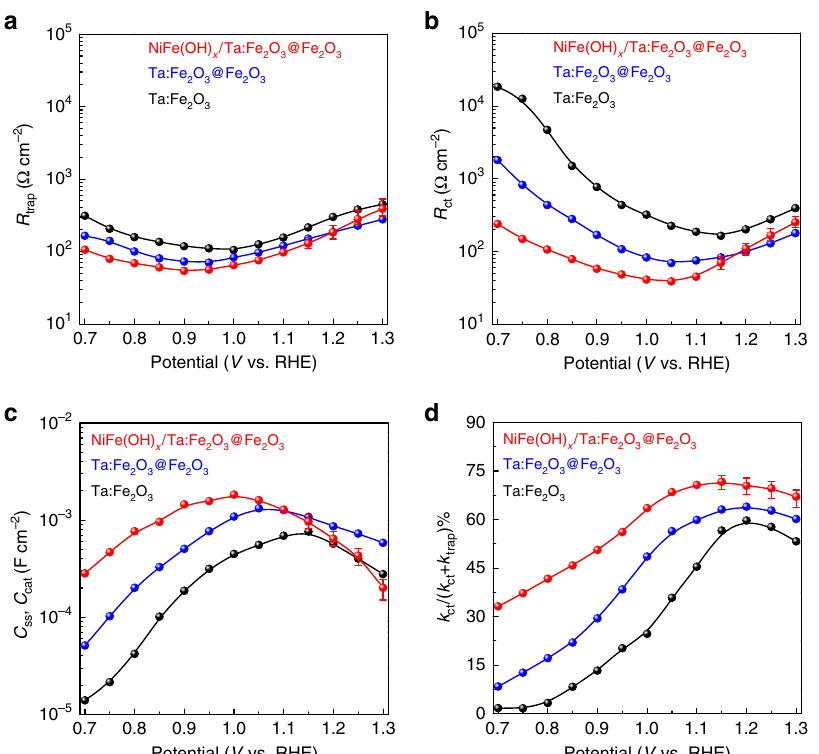
Fig. 5 PEIS of Ta:Fe 2 O 3 , Ta:Fe 2 O 3 @Fe 2 O 3 , and NiFe(OH) x /Ta:Fe 2 O 3 @Fe 2 O 3 photoanodes. a Trapping resistance. b Charge transfer resistance. c Surface states capacitance. d Ratio of the charge transfer rate constant ( k ct ), and the sum of k ct and trapping rate constant ( k trap